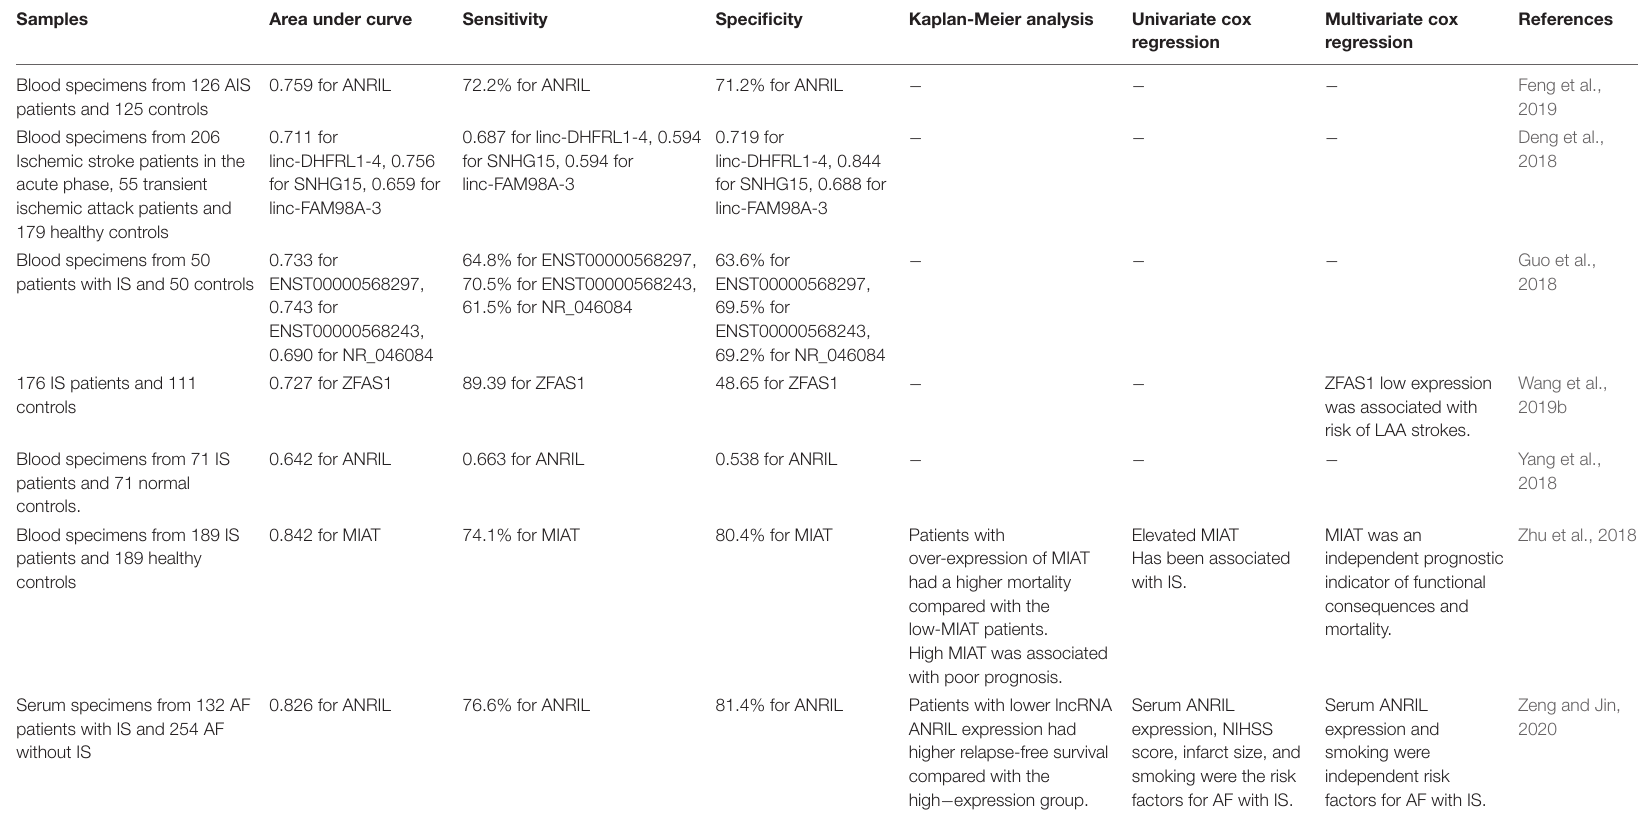
TABLE 3 | Diagnostic/prognostic role of lncRNAs in